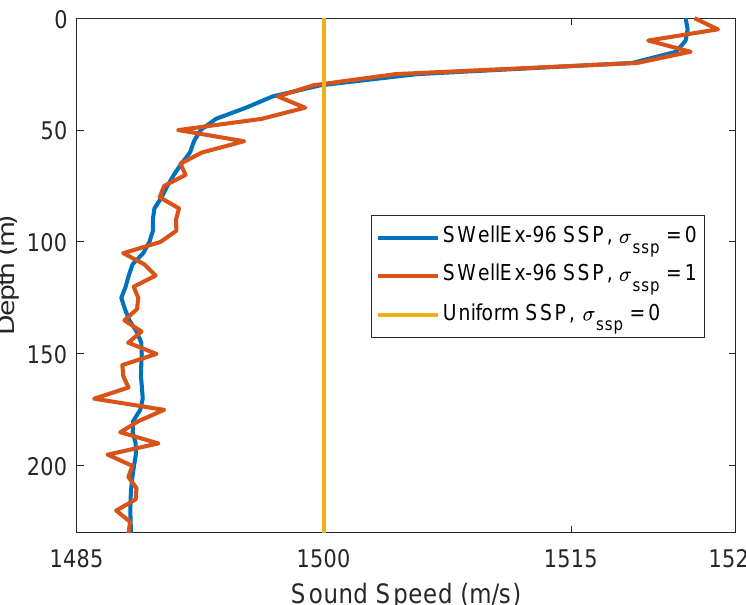
Figure 3. Sound speed profiles (SSPs): uniform, SWellEx-96 [27] and the mismatched SWellEx-96 when the variance sound speed σ 2 ssp = 1 (m 2 /s 2 ) . (Note: there is no change for the SSP when σ 2 ssp = 0, the mismatched is discussed in Section